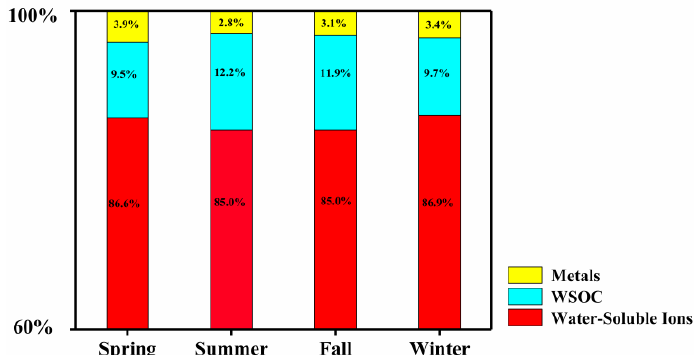
Figure 2. Relative percentages of different chemical components in PM 2.5 . WSOC: water-soluble organic carbon.